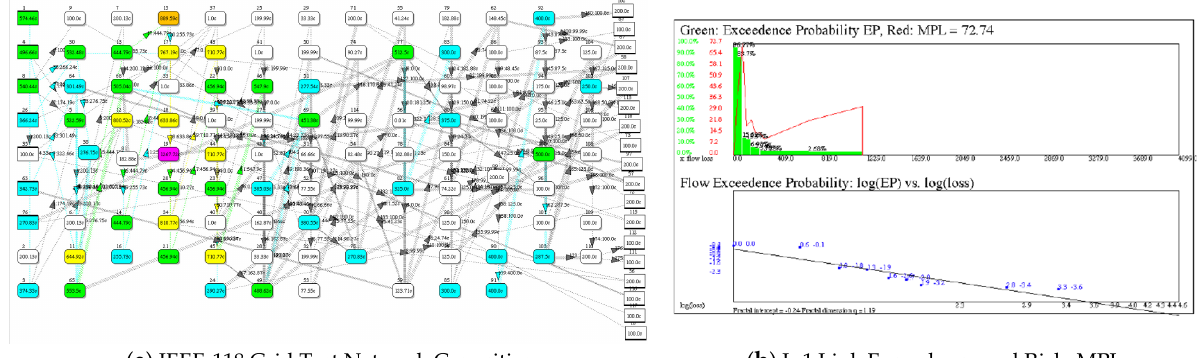
Figure 7. Flow analysis of the IEEE-118 power grid test network. ( a ). The network organized with sources on the left and sinks on the right. ( b ). EP(consequence), R(Consequence) and MPL derived from faulting one link at a time and measuring the resulting cascade. Total flow in is 4100, MPL is 72.74, and q = 1.19. Nodes/links heat map colored according to their capacities.